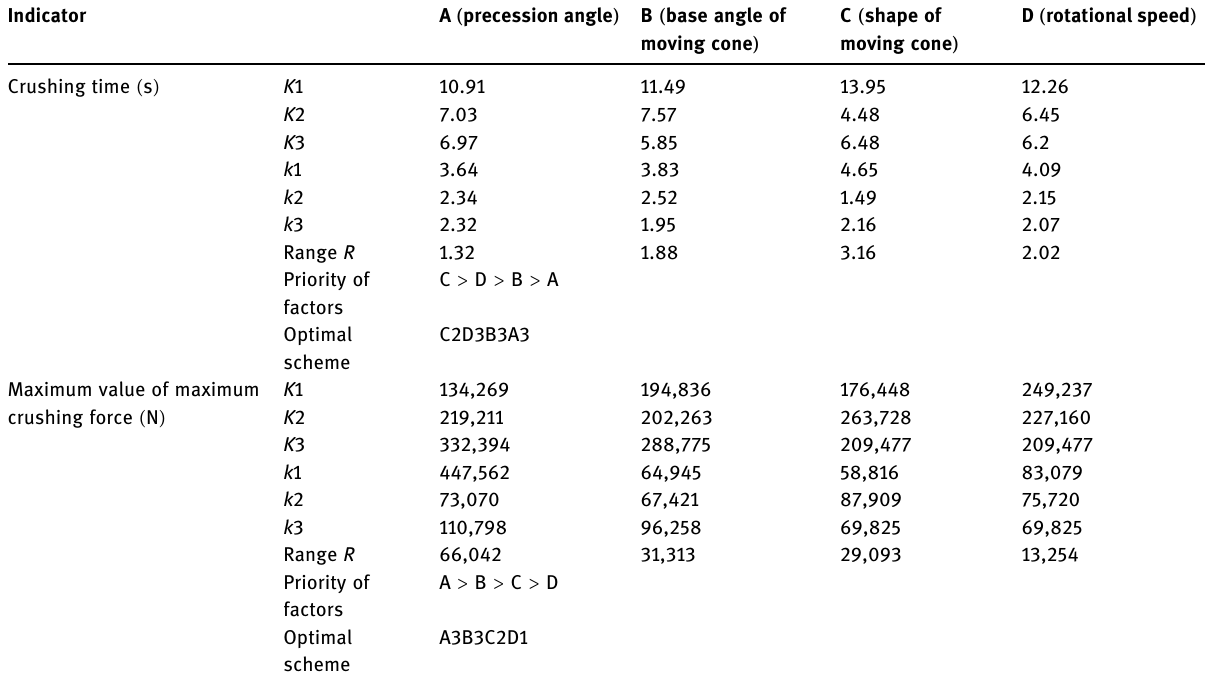
Table 5: Analysis result